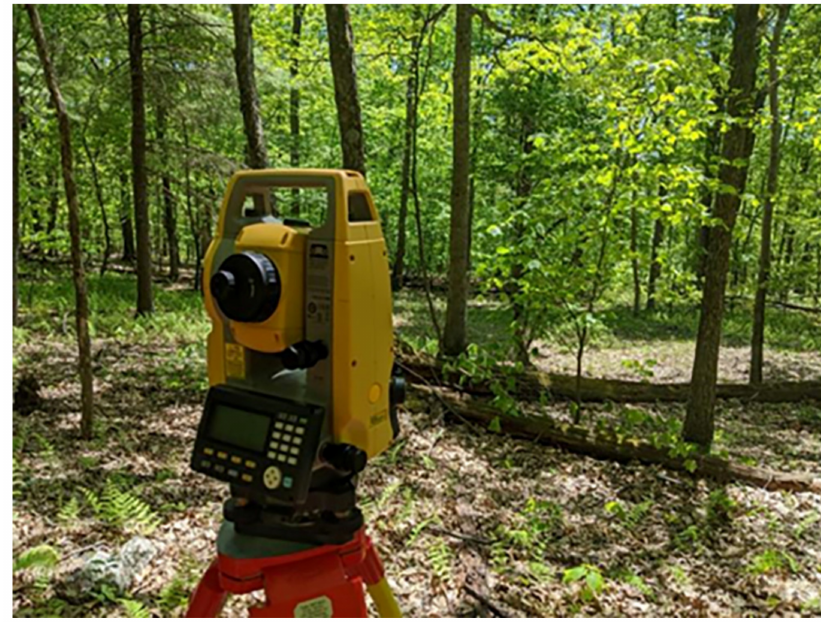
Figure 5. TopCon Total Station ES-105 in use at the study